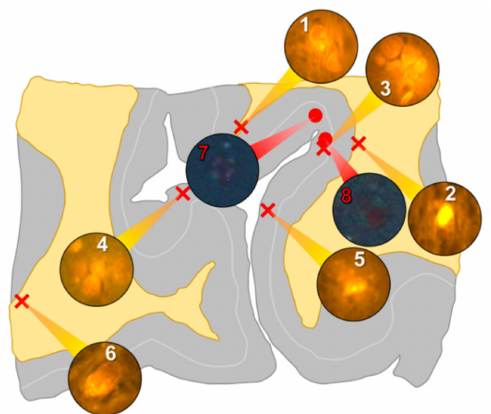
Figure 2. Schematic depicting a 5 µ m tissue section of the occipital lobe. White matter and grey matter are highlighted yellow and grey, respectively. Lumogallion-reactive aluminium was identified through sequential scanning of a 5 µ m tissue section, with positive bright orange fluorescence denoted by red crosses (regions 1–6). On an adjacent serial section, Congo red positive regions showing apple-green birefringence under polarised light identified amyloid and spherulites, denoted by red circles (regions 7 and